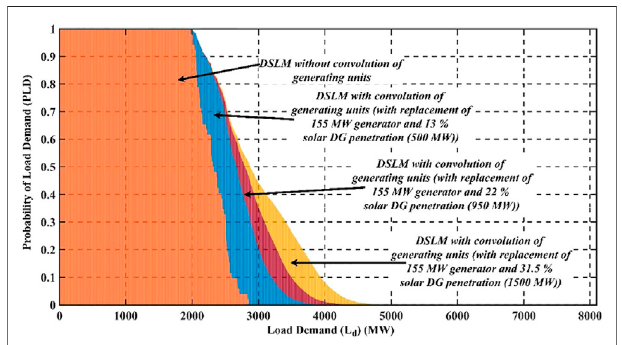
FIGURE 9 | DSLM after convolving all the generating units considering different levels of DG